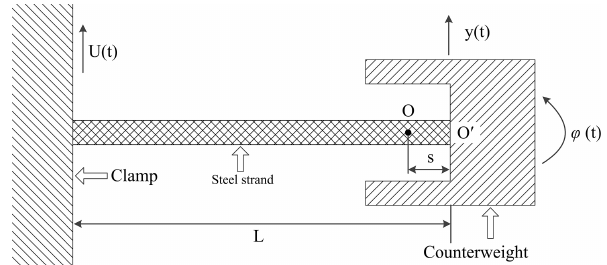
Figure 2. One-side subsystem of the vibration